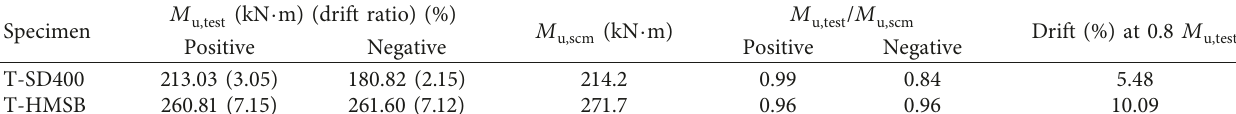
Table 2: Test results and comparison with the theoretical value. Specimen